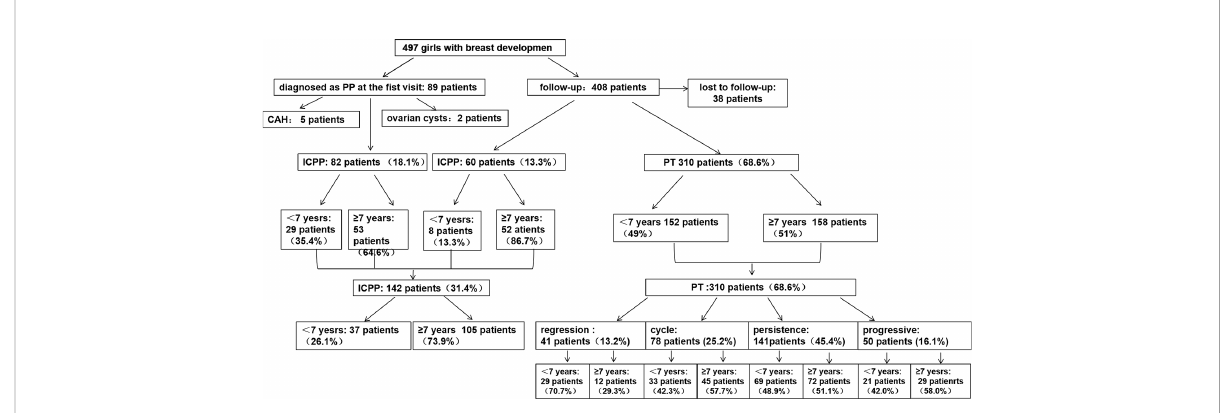
FIGURE 1 Flowchart of participant screening and enrollment. CAH, congenital adrenal hyperplasia; ICPP, idiopathic central precocious puberty; PT, premature